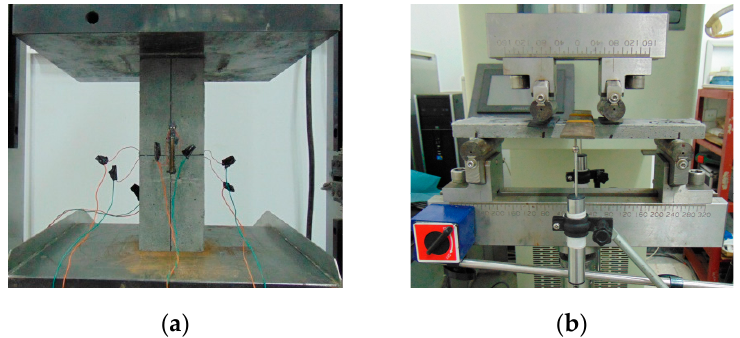
Figure 6. Test setup. ( a ) Axial compressive test. ( b ) Flexural test.